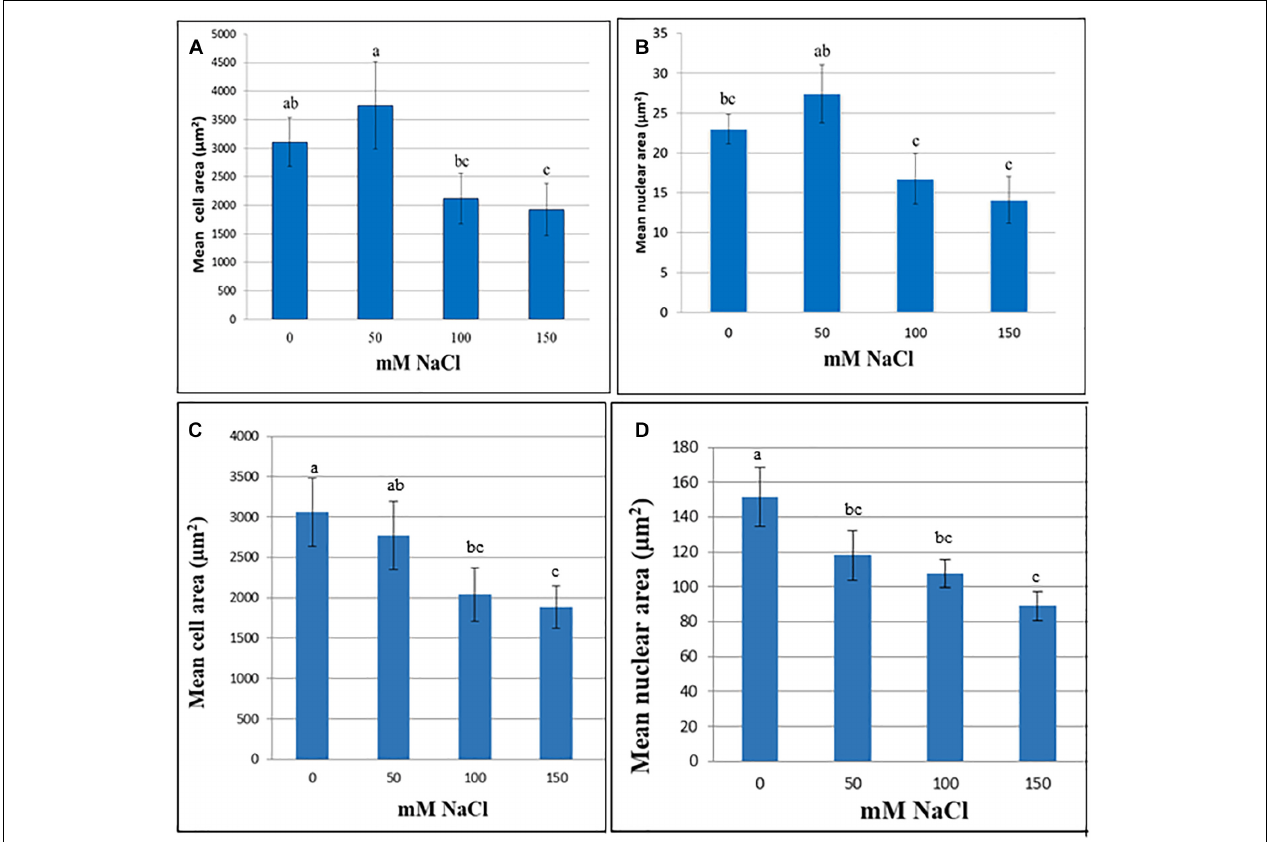
FIGURE 1 | Cell (A,C) and nuclear (B,D) area ( µ m 2 ) at various NaCl concentrations of cell suspensions of M. truncatula (A,B) and N. tabacum (C,D) measured at 60 and 8 days, respectively, following the start of treatment (mean ± SE, n = 12). Letters above bars denote significant differences in area between NaCl concentration datasets ( P <